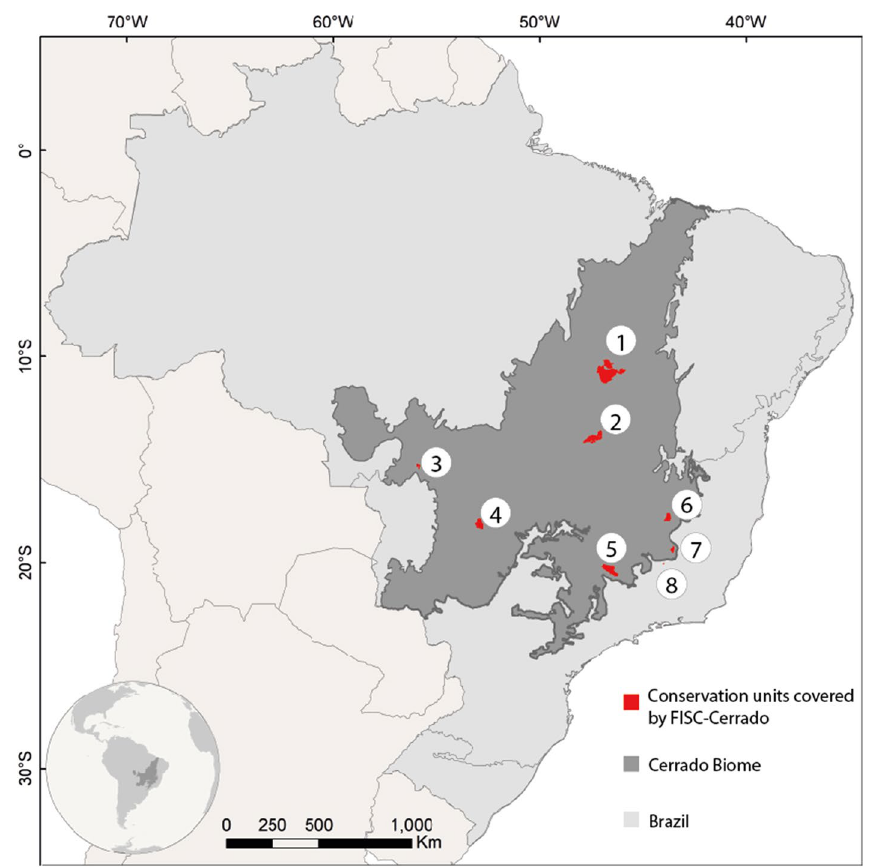
Figure 1. Cerrado biome and regions of the nine conservation units covered by FISC-Cerrado. 1– Jalapão State Park and Serra Geral do Tocantins Ecological Station; 2—Chapada dos Veadeiros National Park; 3—Chapada dos Guimarães National Park; 4—Emas National Park; 5—Serra da Canastra National Park; 6—Sempre-Vivas National Park; 7—Serra do Cipó National Park; 8—Serra do Rola Moça State Park. Map created in ArcGIS 10.1 (http:// www. esri.